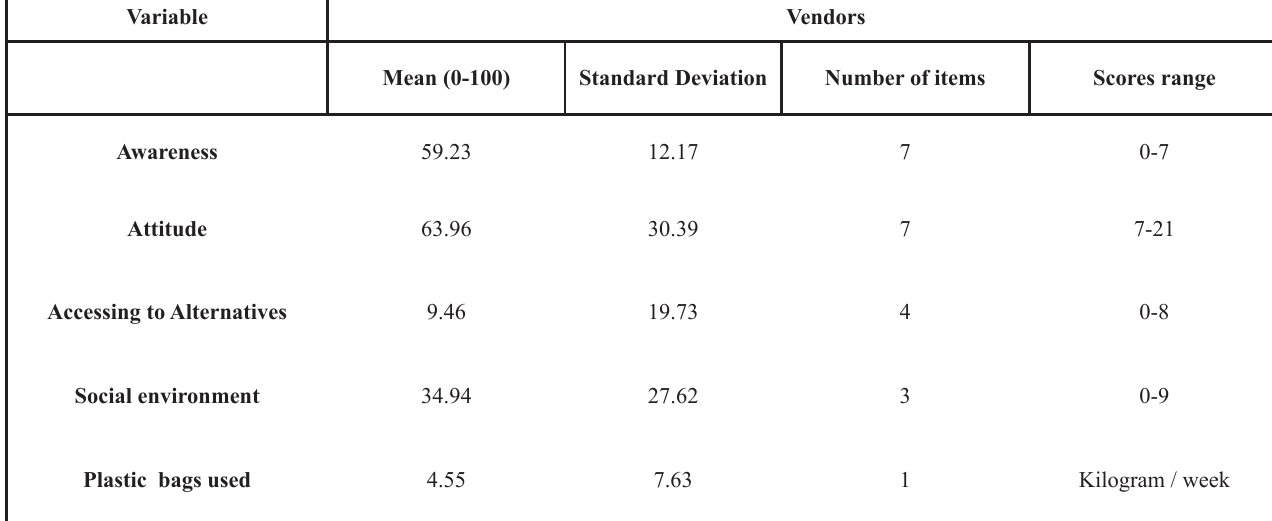
Table 2. Descriptive statistics for individual and environmental factors contributing to the use of plastic bags or their alternative s